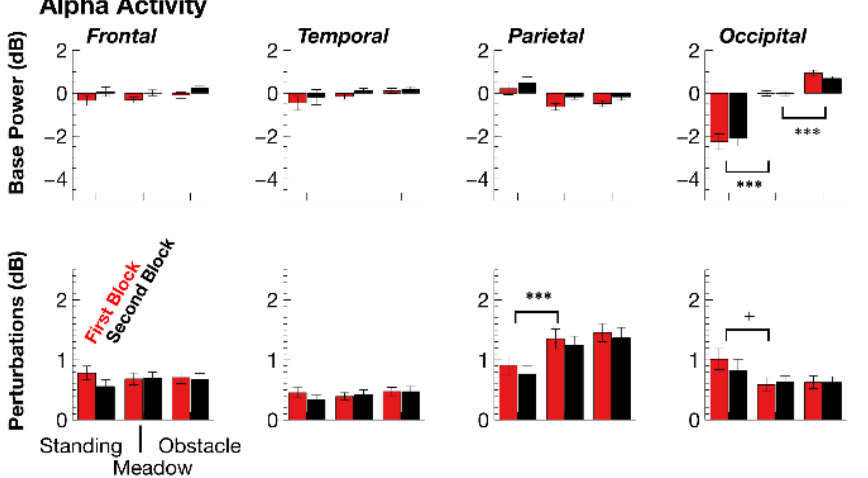
Figure 6. Level of Alpha power and task-related perturbations (means and standard error of means) for the three walking conditions and separated for the two blocks. Alpha level increased with walking complexity at occipital sites. Alpha perturbations were increased for both walking conditions at parietal sites and decreased at occipital sites. Significant effects of walking condition are depicted for all pairwise comparisons (***: p < 0.001; +: p < 0.1).